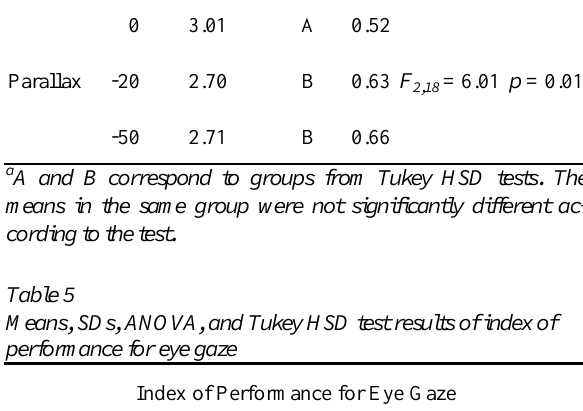
Means, SDs, ANOVA, and Tukey HSD test results of index of performance for hand click Index of Performance for Hand Click Level Mean (bits/s) Group a SD